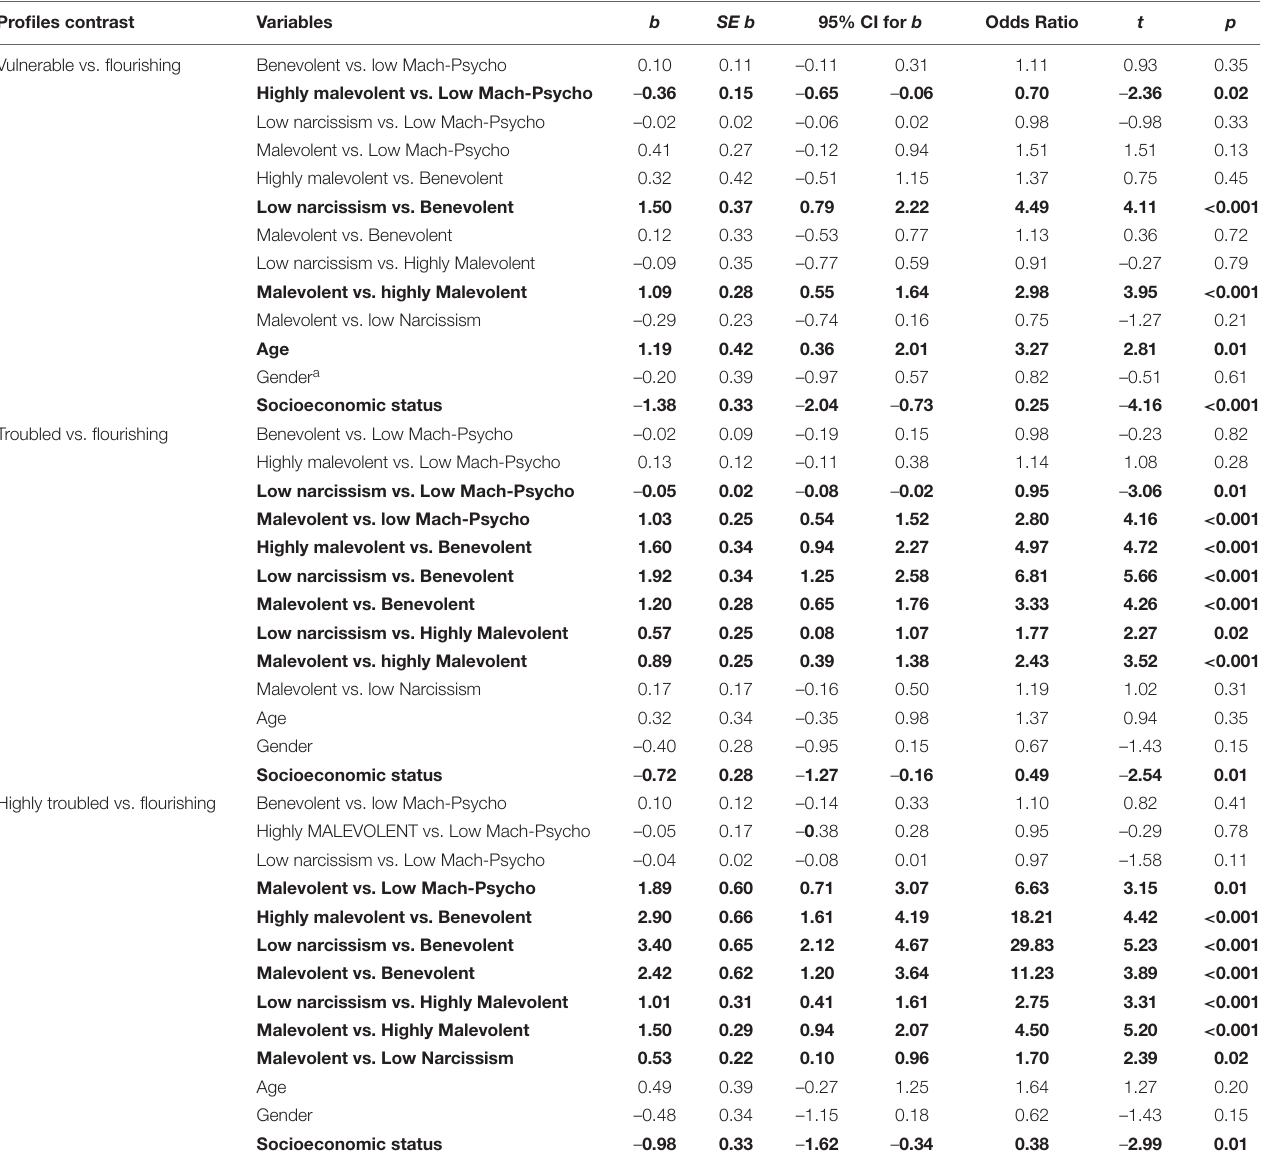
TABLE 6 | Multiple multinomial regression analysis predicting mental health profiles. Profiles contrast Variables b SE b 95% CI for b Odds Ratio t p Vulnerable vs. flourishing Benevolent vs. low Mach-Psycho 0.10